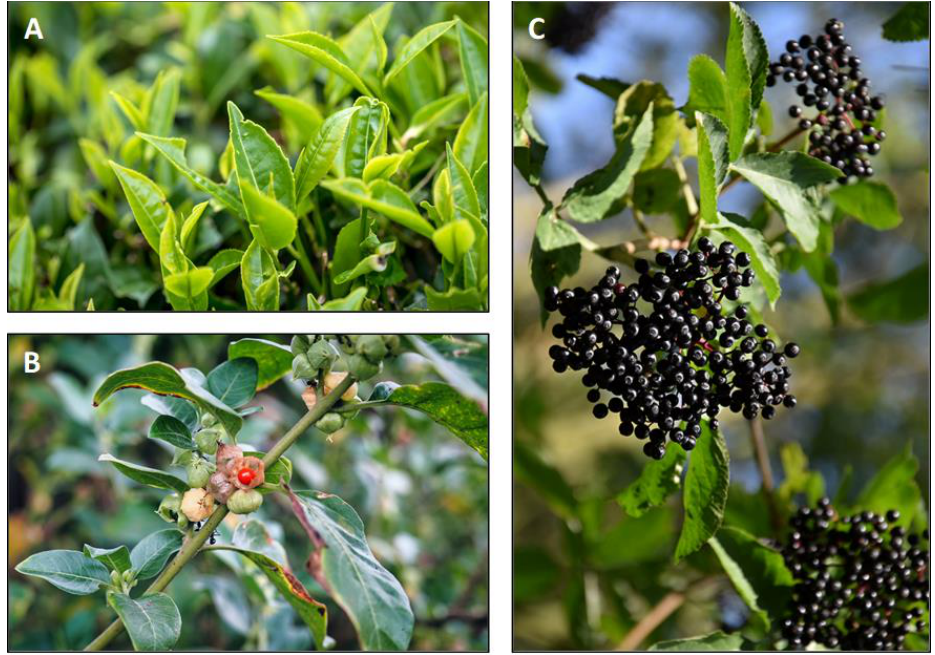
Figure 1. Botanical pictures of Camellia sinensis (A), Withania somnifera (B) and Sambucus nigra